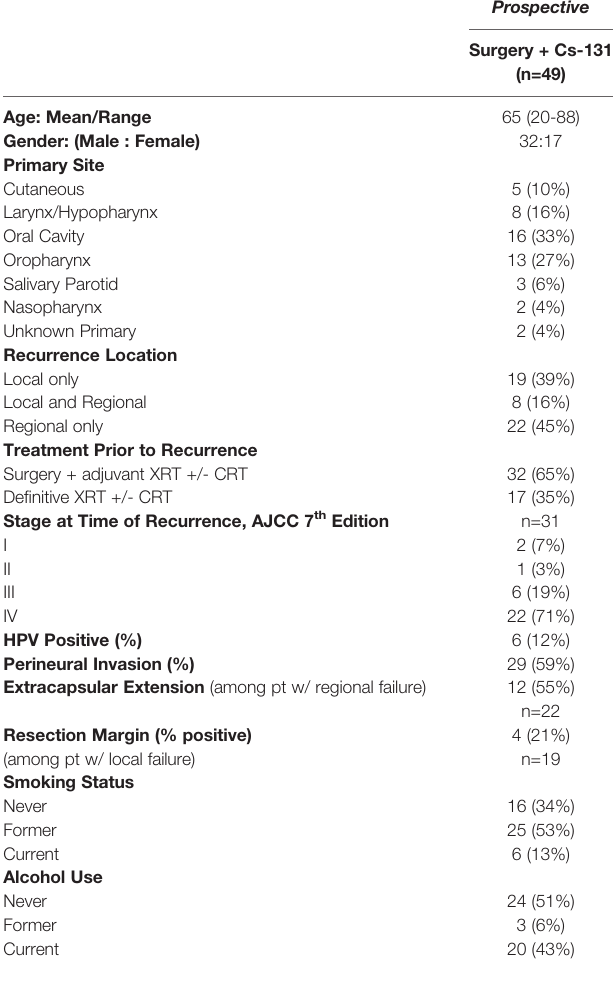
TABLE 1 | Demographic and tumor characteristics of the prospective cohort.